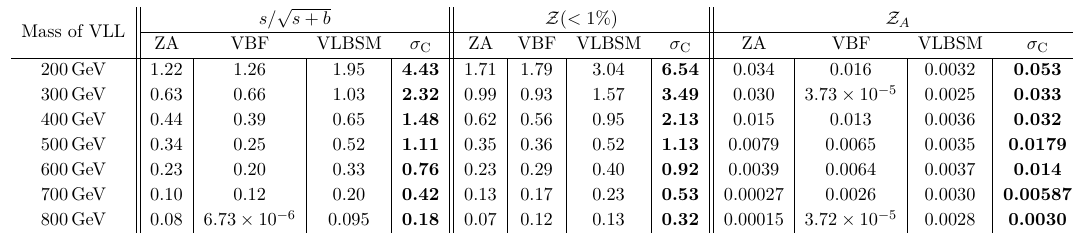
Table 7. Signal significance for the lightest VLL. The computation follows an evolutive algorithm that maximizes the Asimov significance metric. All significances are computed for L = 9000 fb − 1 √ s = 14 TeV. σ C is the combined significance as defined in (5.4). with centre-of-mass energy of √ s/ s + b Z ( < 1%) Z A Mass of VLL